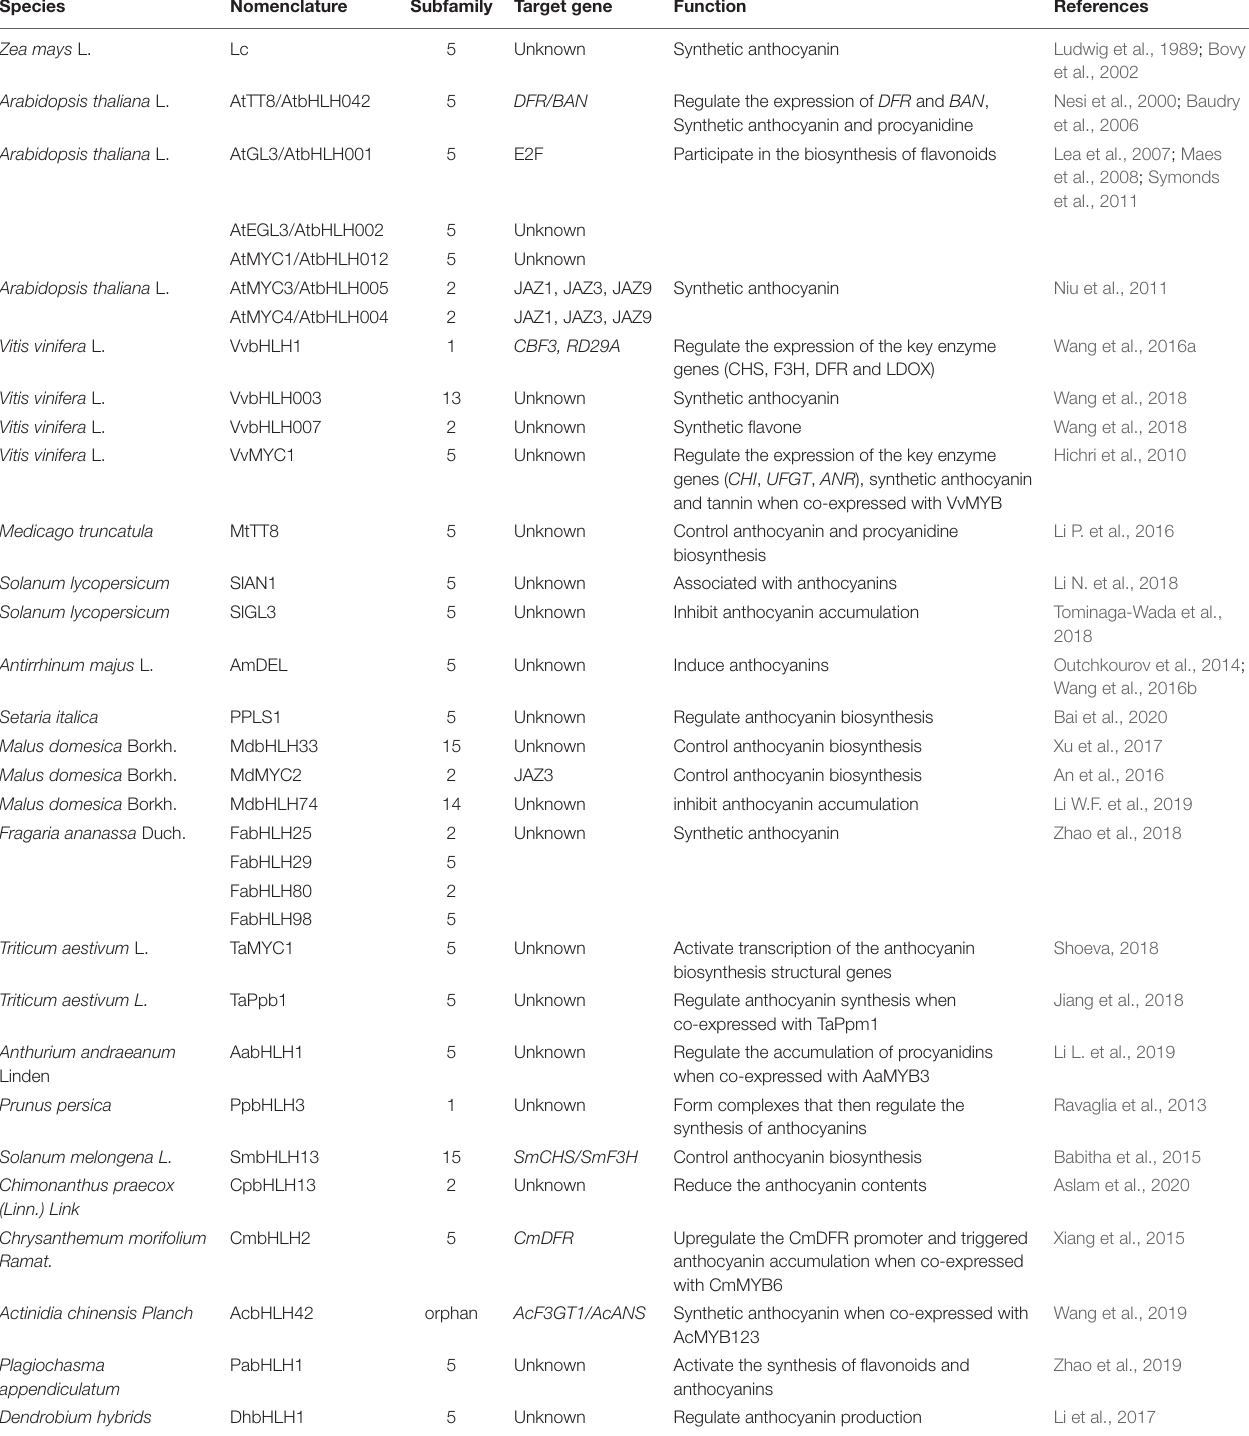
TABLE 3 | Regulation of bHLH transcription factors on metabolism of flavonoids.